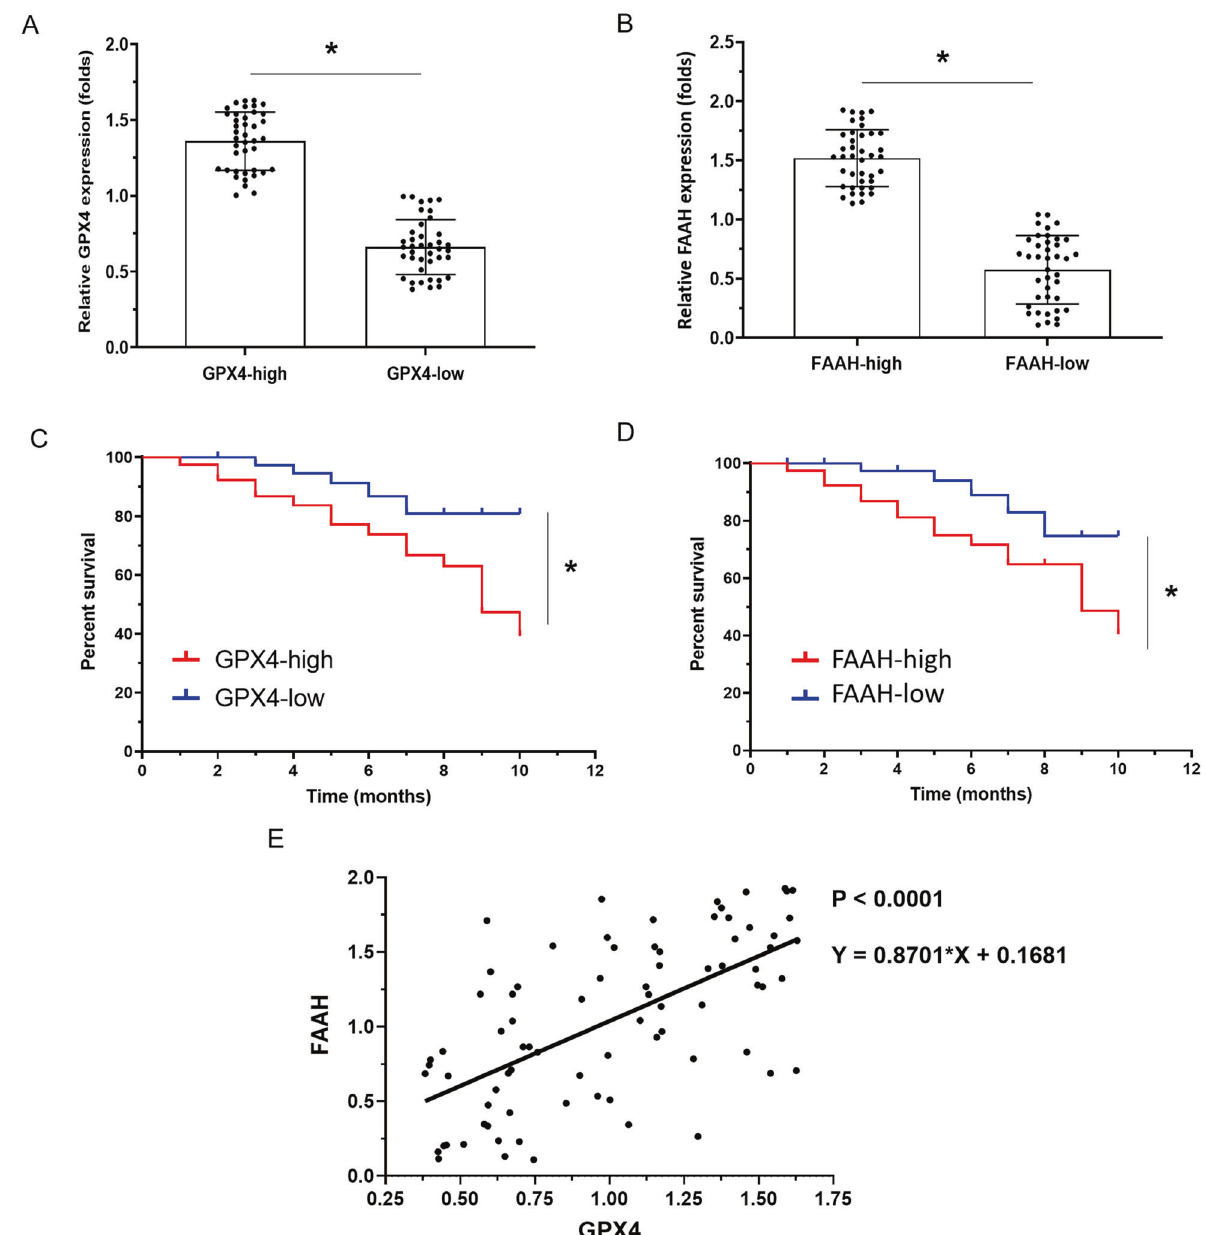
Fig. 1 The clinical signi fi cance of FAAH and GPX4 in advanced ccRCC. Quantitative polymerase chain reaction was used to detect the expression of FAAH and GPX4 in clinical specimens from ccRCC patients. ( A , B ) Patients were divided into two groups (high-expression group or low-expression group) according to their median expression of GPX4 ( A ) and FAAH ( B ). The results are displayed as scatter plots and histograms. Clinical analysis was performed based on follow-up data from patients ( C , D ). The prognosis of patients (overall survival) in the high/low groups of GPX4 ( C ) or high/low groups of FAAH ( D ) is shown as a survival curve. * P < 0.05. (v/v/v) solution. After mixing and phase separation by centrifugation, were randomly divided into groups and injected intraperitoneally with the organic layer was recovered and dried under a stream of N2. The URB597 (30 mg/kg) and RSL3 (30 mg/kg); control animals were injected resulting lipid extracts were puri fi ed by solid-phase extraction using with an equivalent volume of saline. Images of xenograft mice were silica and elution with an EtOAc-Acetone (1:1) solution. The resulting obtained with a Xenogen IVIS 2000 Luminal Imager once a week. For the lipid fraction was analyzed by HPLC-MS using an LTQ Orbitrap mass animal experiments ’ statement about randomization: animals were spectrometer coupled to an Accela HPLC system (Thermo Fisher randomly numbered and randomly assigned to groups based on a Scienti fi c). Analyte separation was achieved using a C-18 Supelguard random number table method, and there was no subjective preference or pre-column and a Supelcosil LC-18 column (3 μ M, 4.6 × 150 mm) subjective in fl uence in the selection of animals for each group. (SigmaAldrich, Saint Louis, MO, USA). Endocannabinoid levels were quanti fi ed by isotope dilution using their respective deuterated Endocannabinoid quanti fi cation by HPLC-MS standards with identical retention. The data were normalized by tumor Endocannabinoid levels in 786-O tumors were quanti fi ed by directly sample weight in the in vivo testing. homogenizing the tissue in mixture of chloroform-methanol-water 4:2:1